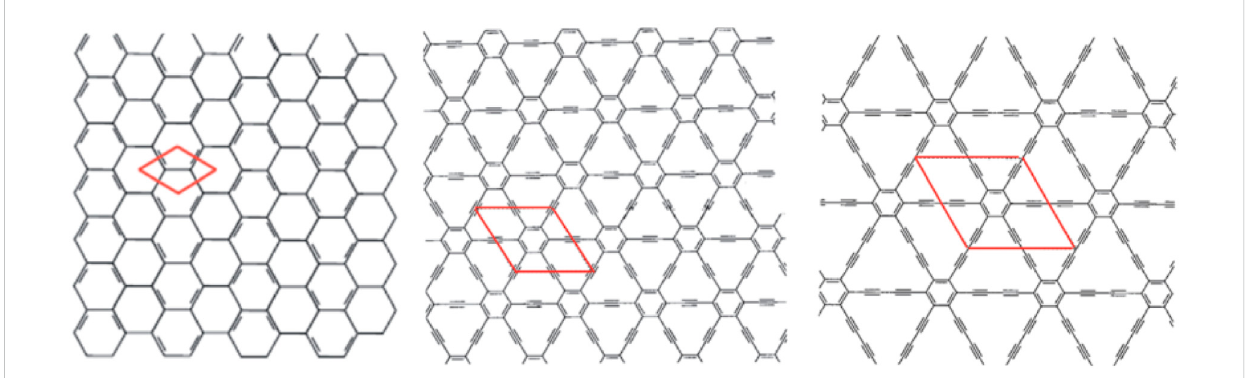
FIGURE 2 Structures of graphene (left), graphyne (middle), and graphdiyne (right). Each red parallelogram represents one unit cell. Reproduced by M. Inagaki and F. Y. Kang, J. Mater. Chem. A, 2014, 2, 13,193 – 13206, with permission of The Royal Society of Chemistry (Inagaki and Kang, 2014).